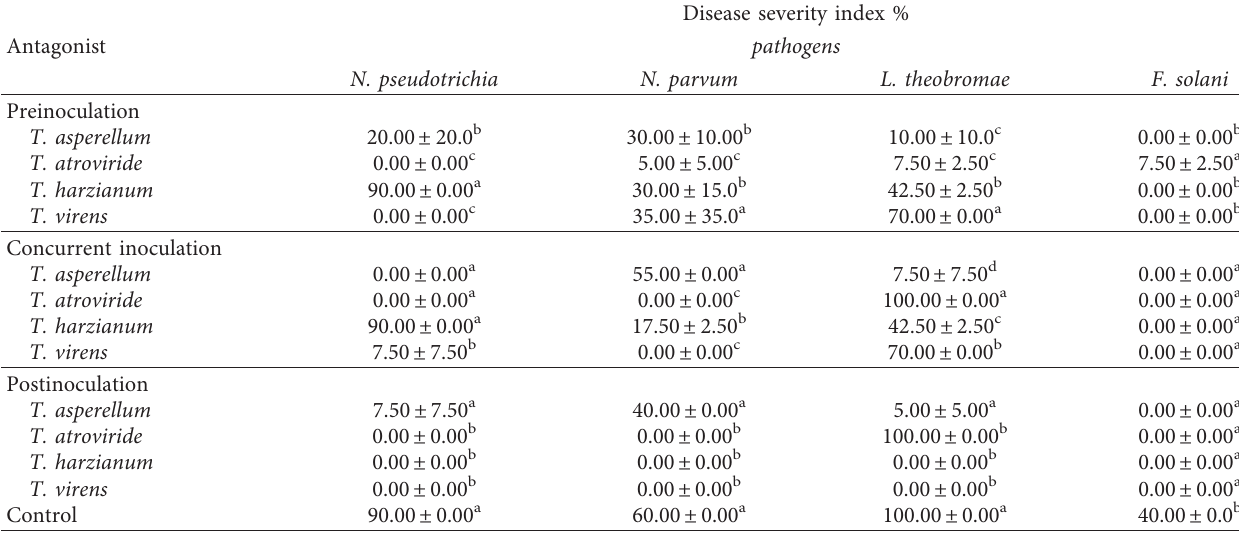
Table 3: Effect of Trichoderma spp. on the severity of SER on postharvest “Hass” avocado